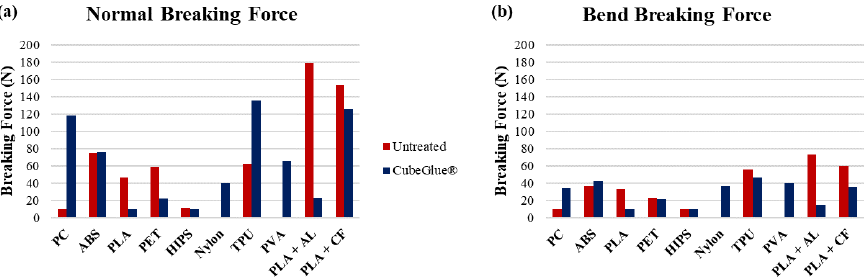
Figure 21. Comparison of magnitude and consistency of normal and bend breaking force, where ( a ) shows the comparison for the normal force and ( b ) the bending force cases.